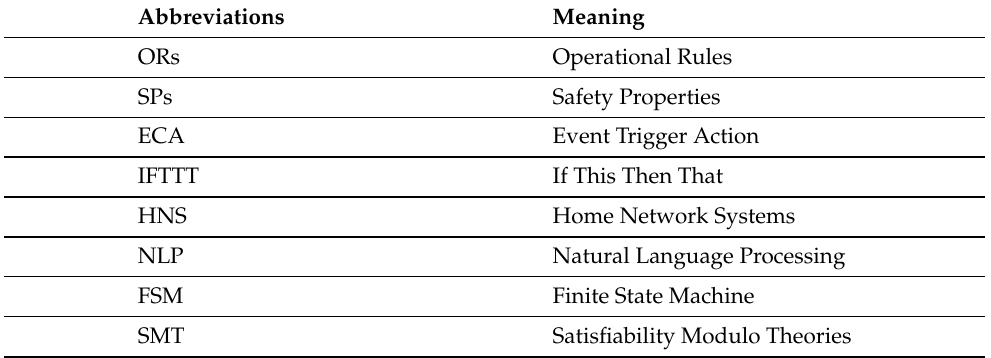
Table 1. Table of